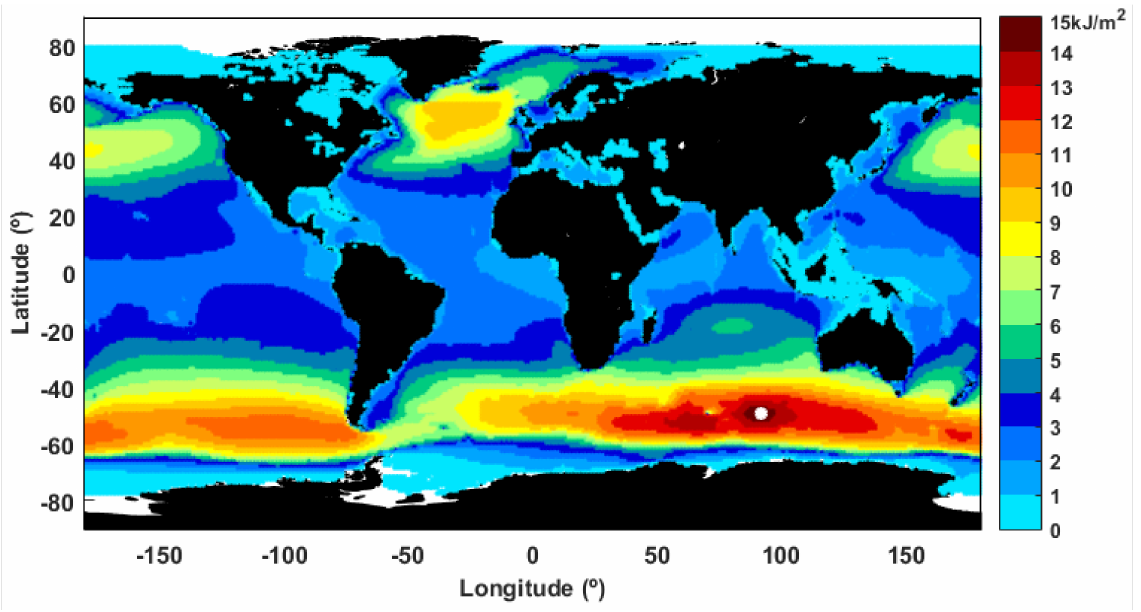
Figure 7. Mean wave energy density ( E w-ERA5 ) over the 27-year time interval (1992–2018) based on ERA5. In order to have a better image of the maximum values of the mean wave energy ( E w ) registered in each hemisphere according to the two datasets, these maximum values are illustrated in Figure 8 (SH: Southern Hemisphere; NH: Northern Hemisphere). The evalu- ation was made both for all data and each season separately. As previously mentioned, the partition for the months of the year corresponds to the seasons from NH. It can be noticed that the maximum values computed in SH are in general about one and a half times larger than in NH, for both datasets. The results also show that in each hemisphere, the E w maximum values computed from CCI-SS dataset are higher by about 11% in comparison with those resulted from ERA5. Only in DJF, the E w maximum values computed from CCI-SS are higher by about 50% and 21% in SH and NH, respectively.